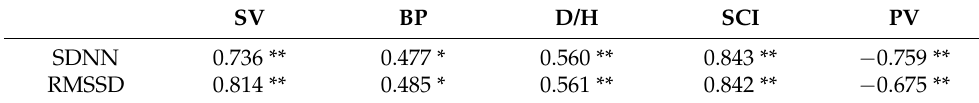
Table 2. Pearson correlation between heart rate variability of spatial attribute elements.